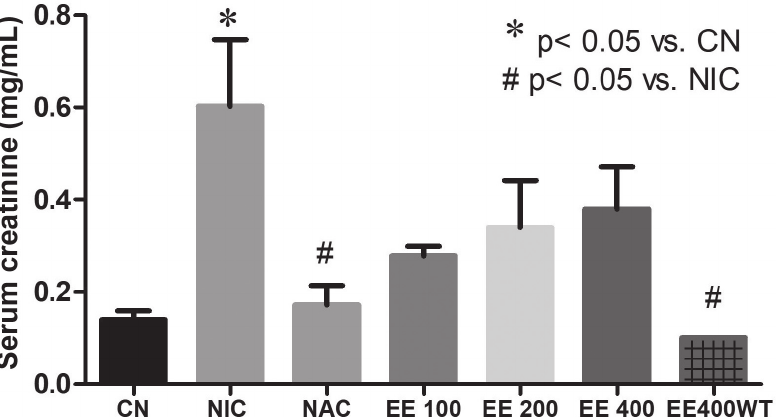
FIGURE 1 - Serum creatinine level in mice treated for 5 days before the induction of NIC. Groups: CN, negative control; NIC, contrast nephropathy; NAC, 100 mg/kg N -acetylcysteine; EE100, 100 mg/kg E. edulis + NIC; EE200, 200 mg/kg E. edulis + NIC; EE400, 400 mg/kg E. edulis + NIC; and EE400WT, control 400 mg/kg E. edulis .